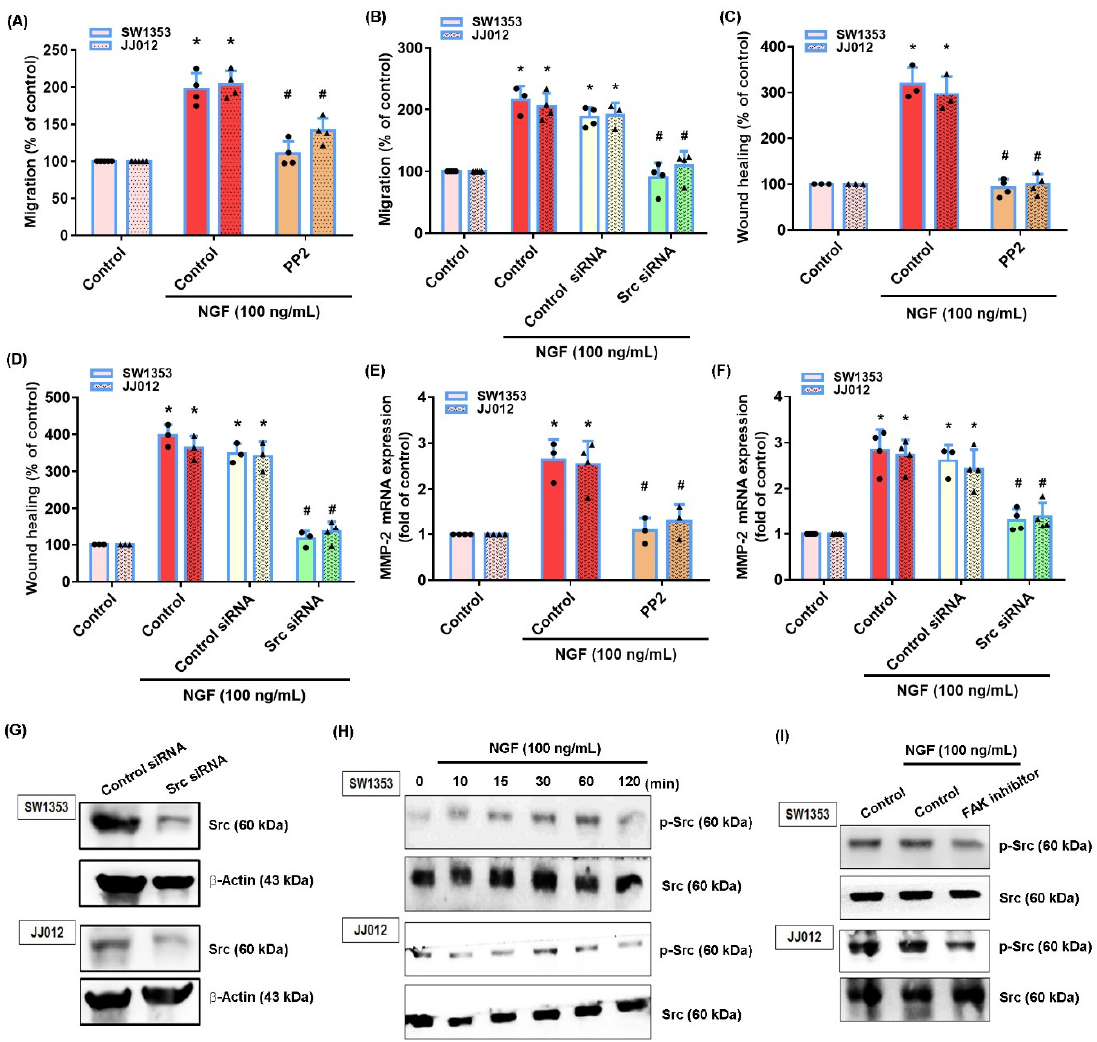
Figure 4. The c-Src pathway mediates NGF-induced MMP-2 expression and cell migration. ( A – F ) Cells were pretreated with a c-Src inhibitor (PP2) or transfected with a c-Src siRNA then stimulated with NGF. The cell migration and levels of MMP-2 expression were examined by Transwell, wound healing and qPCR assays. ( G ) Cells were transfected with a c-Src siRNA and c-Src expression was examined by Western blot. ( H , I ) Cells were incubated with NGF for the indicated time intervals or pretreated with a FAK inhibitor then stimulated with NGF; c-Src phosphorylation was examined by Western blot. * p < 0.05 compared with the control group; # p < 0.05 compared with the NGF-treated group.